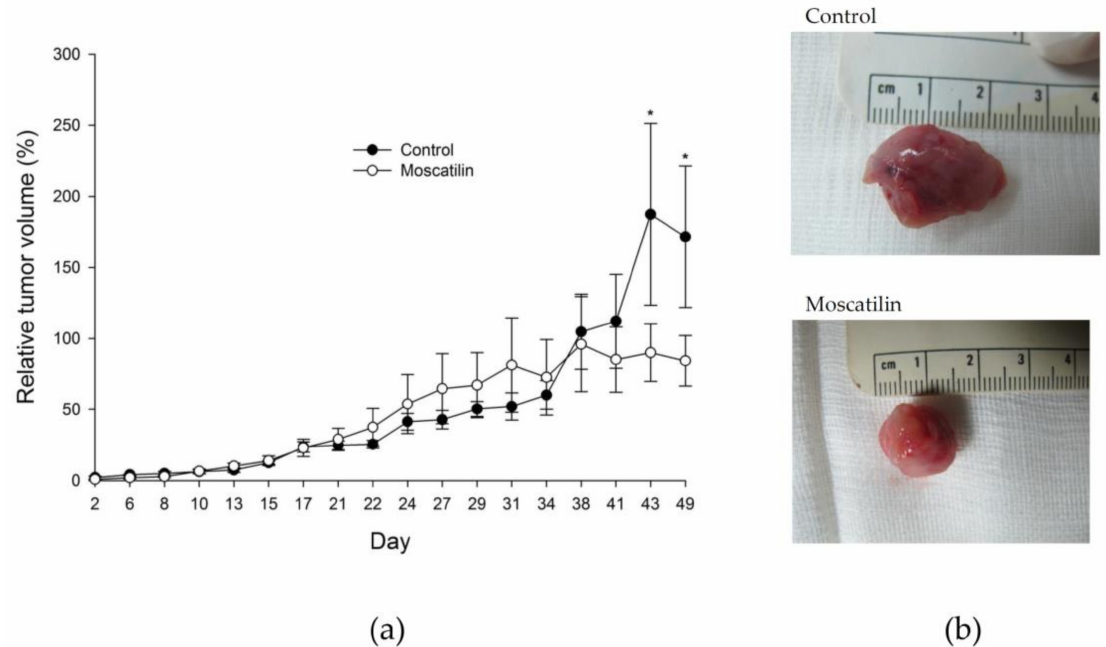
Figure 1. Moscatilin inhibited esophageal cancer tumor growth in vivo. The tumor size observed in the moscatilin-treated group (50 mg/kg) decreased significantly compared with tumor size in the control group * p < 0.05 ( a ). Representative photographs of tumor specimens of control and moscatilin-treated mice, as indicated ( b